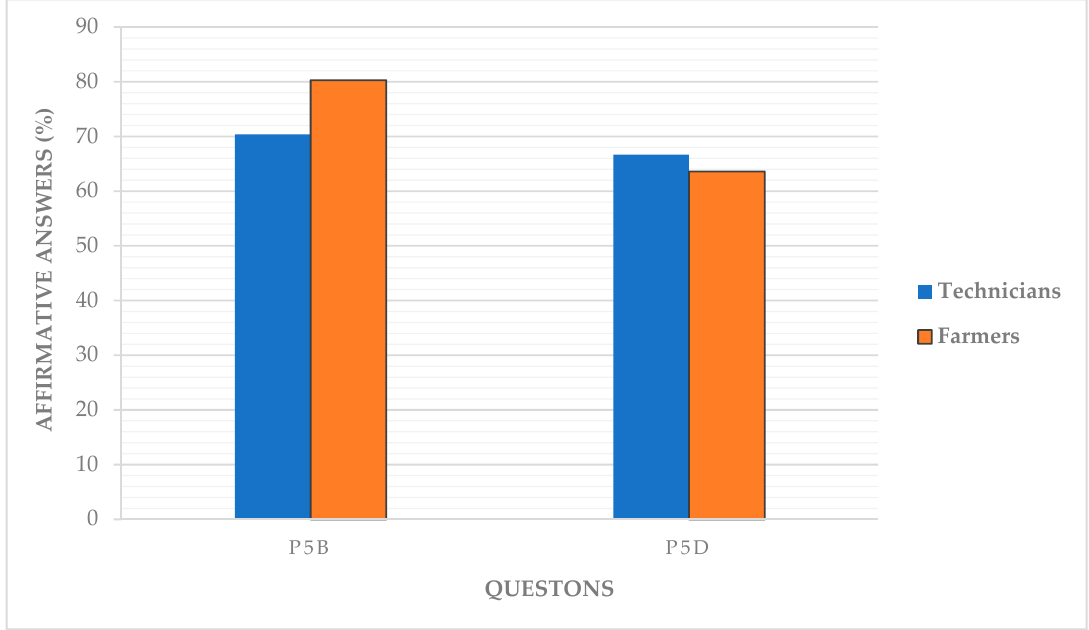
Figure 11. Answers for questions in Block 4 (technicians and managers).